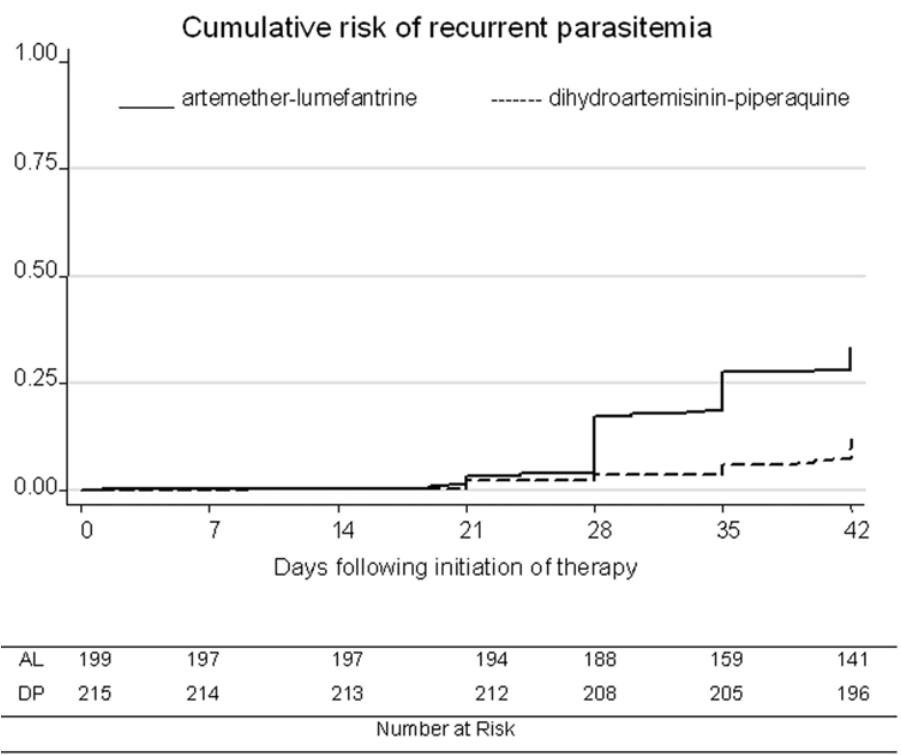
Figure 2. Cumulative risk of recurrent parasitaemia, unadjusted by genotyping. AL=artemether-lumefantrine; DP=dihydroartemisinin- piperaquine.